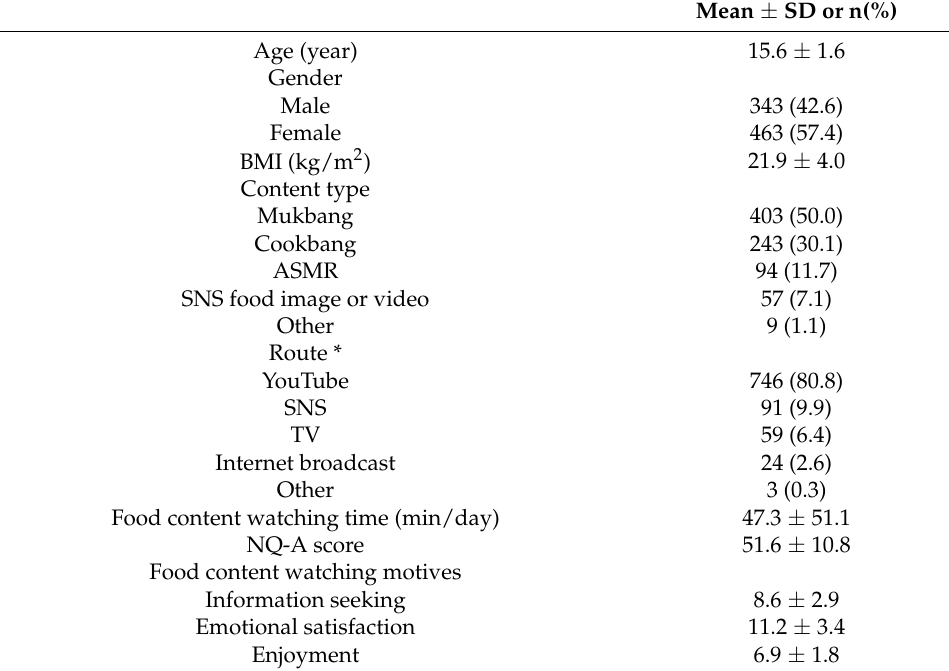
Table 2. General characteristics of the subjects and the use of food-related content (N = 806).